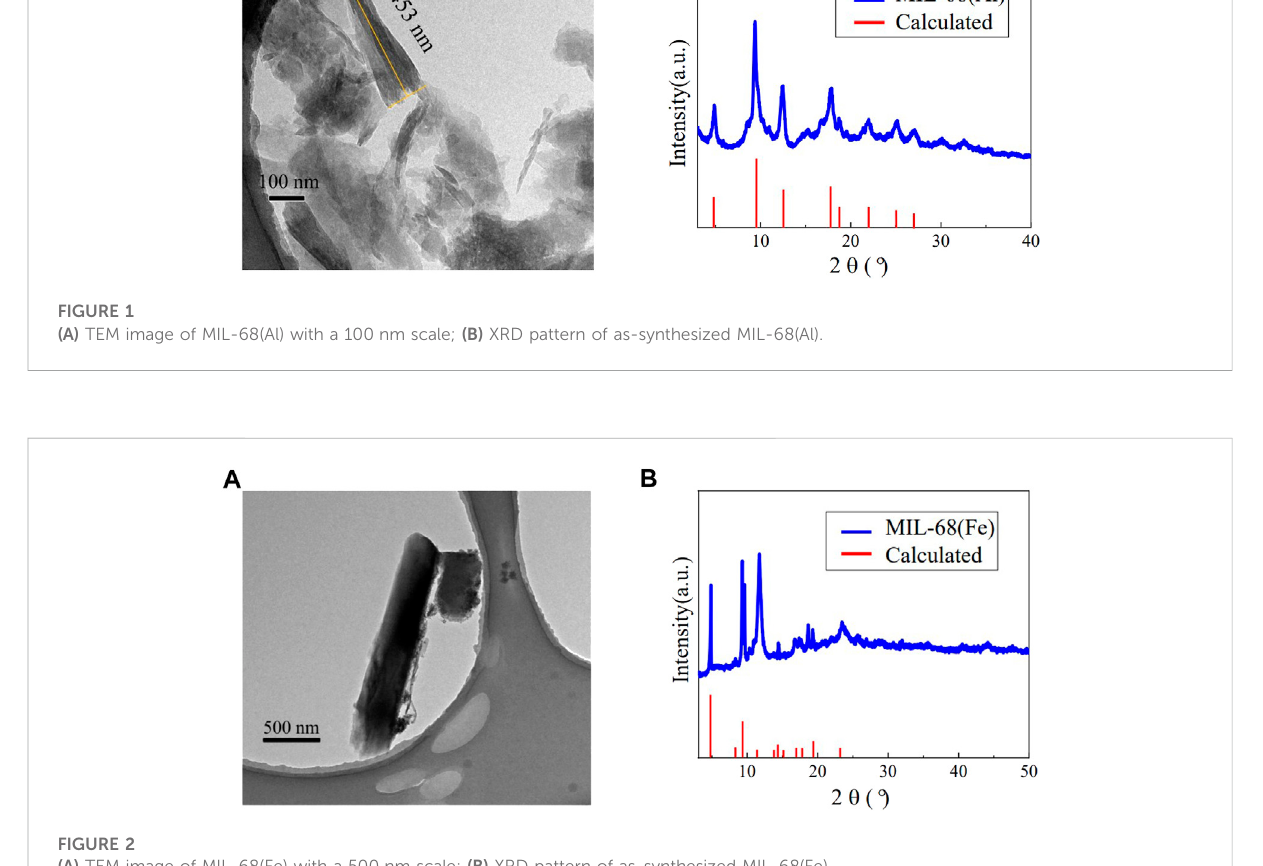
numerical aperture (NA) of 0.22. The gain fi ber was pumped via